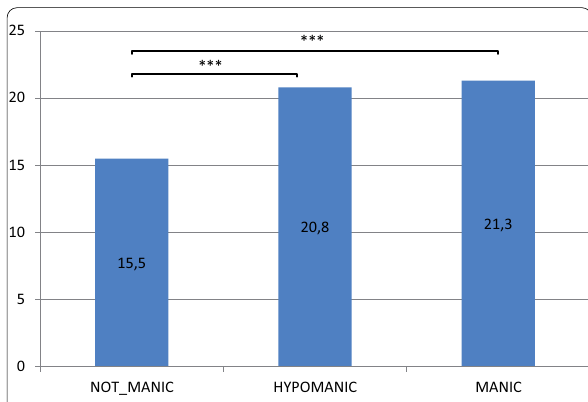
Fig. 2 Average IDS-C scores by state (based on 4-item YMRS core-score), EVEN